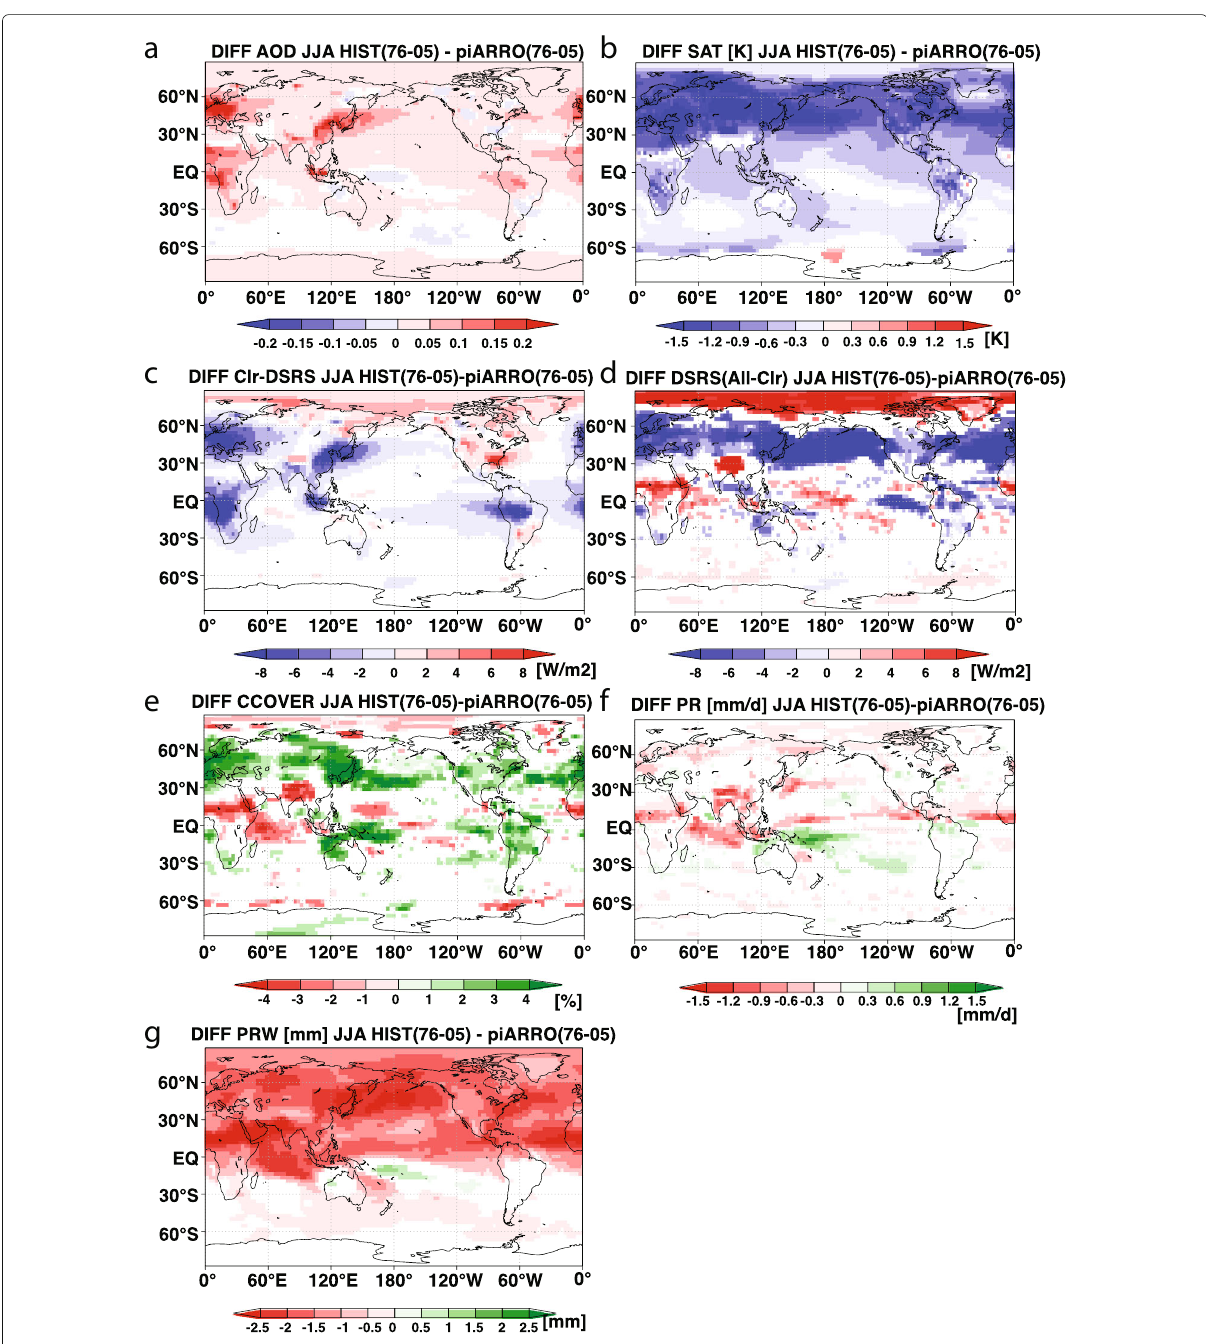
Fig. 3 Differences in 30-year climatological a AOD, b SAT, c clear-sky downward shortwave radiation at the surface (DSRS), d the difference between all-sky DSRS and clear-sky DSRS (indirect effect), e cloud cover, f precipitation, g precipitable water during JJA between the ensemble-averaged HIST and piAERO (HIST - piAERO). Both HIST and piAERO values were averaged over the 30-year period from 1976 to 2005. All differences are shown when the local statistical significance level is at least 95%, as determined by Student’s t